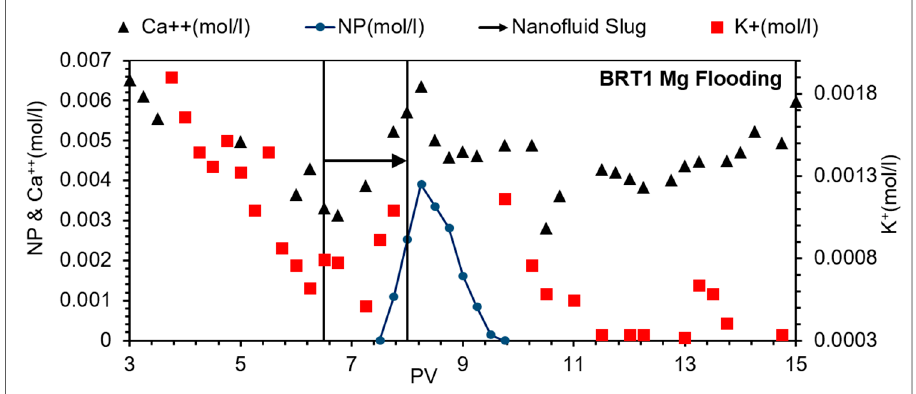
Figure 7. Effluent concentrations of NPs and ions for BRT1; Mg brine flooding. Figure 7. E ffl uent concentrations of NPs and ions for BRT1; Mg brine